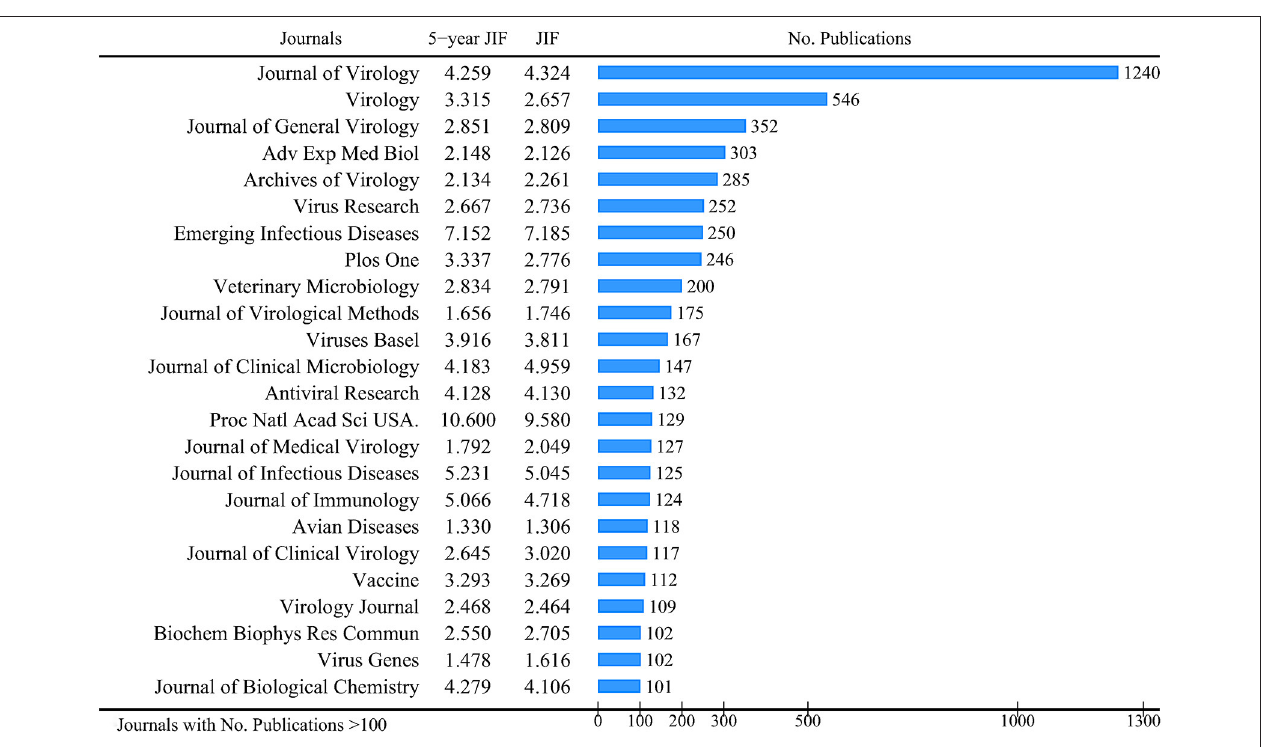
FIGURE 2 | Journals with more than 100 CoV-related